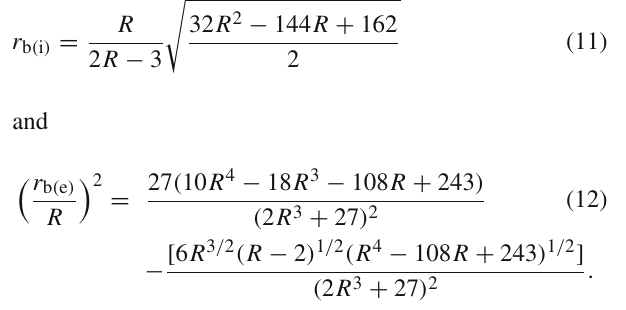
areas indicate the zones of trapped null geodesics: the darker one corresponds to null geodesics fully contained in the inter- nal spacetime (with inner boundary at r b ( i ) ), while the